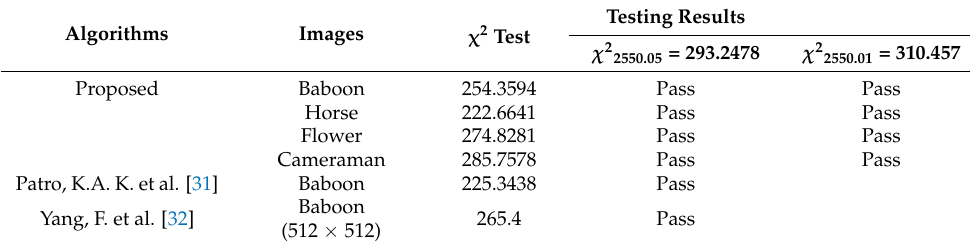
Table 4. The Chi-square test